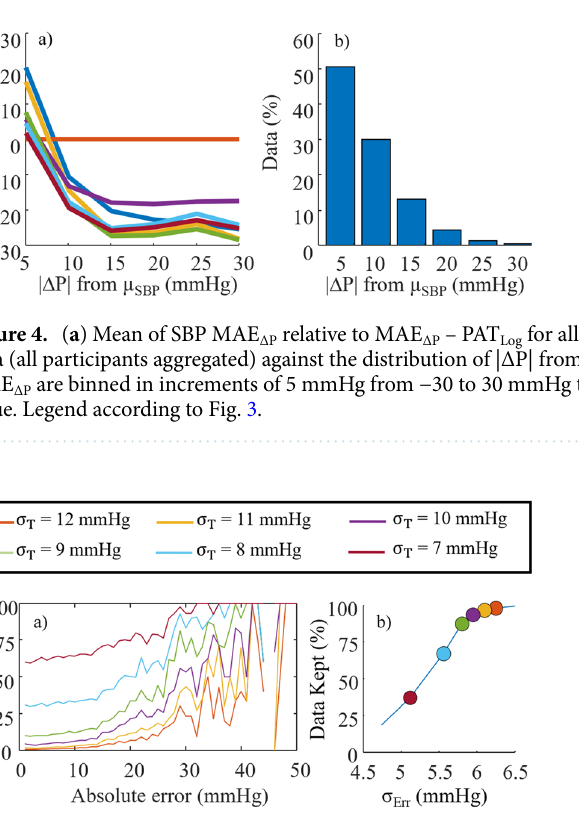
Figure 5. For the NARX + ANN Sys + PAT Log model, ( a ) percentage of the data removed as a function of the absolute error using different σ T . The results are calculated from all the test data from every participant and grouped in increments of 1 mmHg. ( b ) Percentage of data kept as a function of the error standard deviation when varying the threshold on the prediction interval. The line was computed by varying the σ T , where specific values are marked with circles according to the legend.